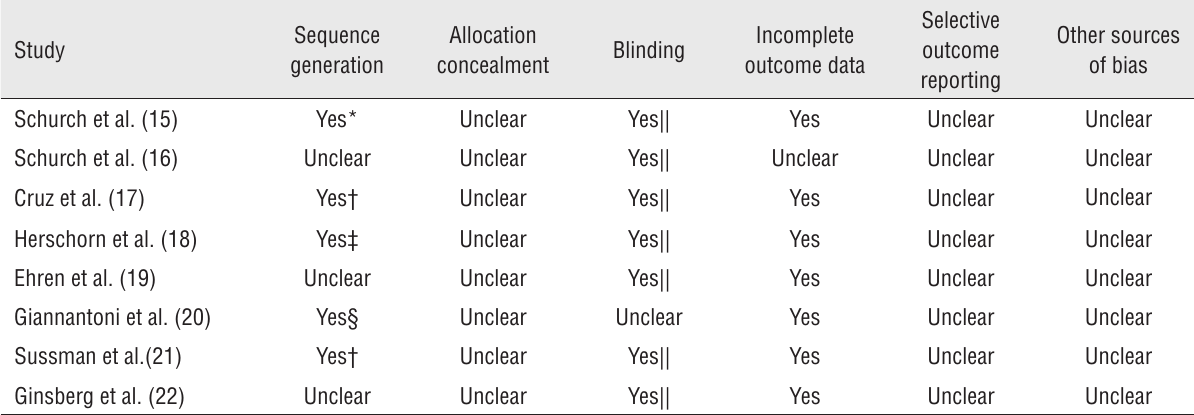
Table 2 - Risk of bias in included